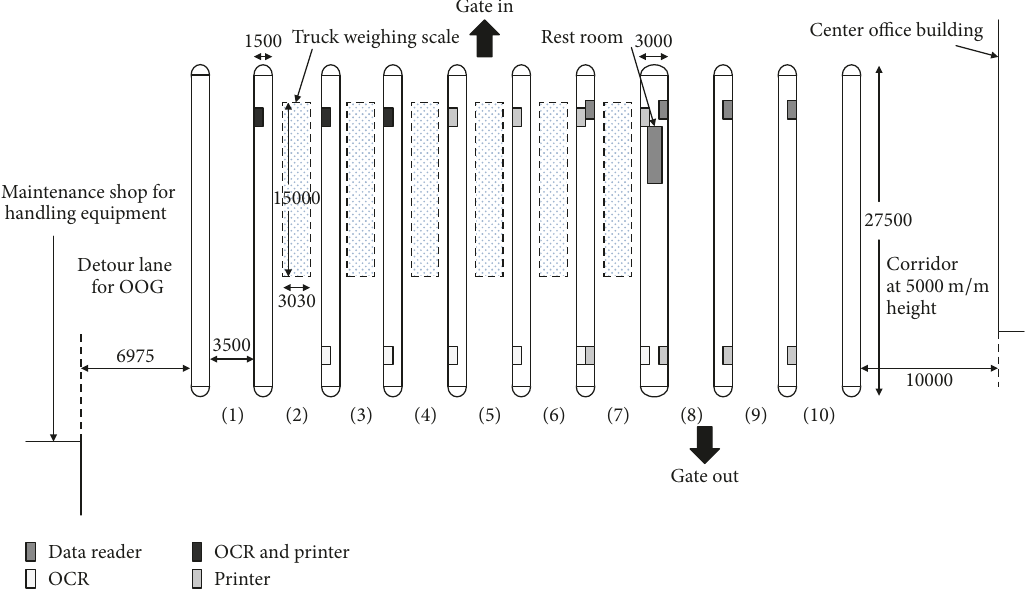
Figure 1: Lanes setting and scheduling for gate in a real container